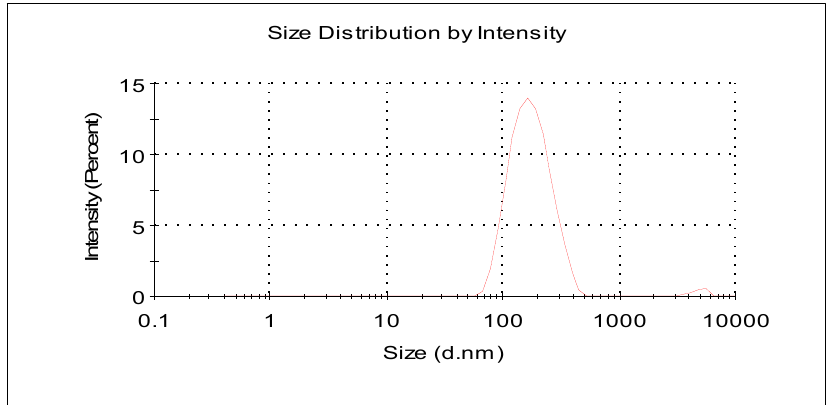
Figure 2. The particle size of the optimized C3G nanoliposomes.